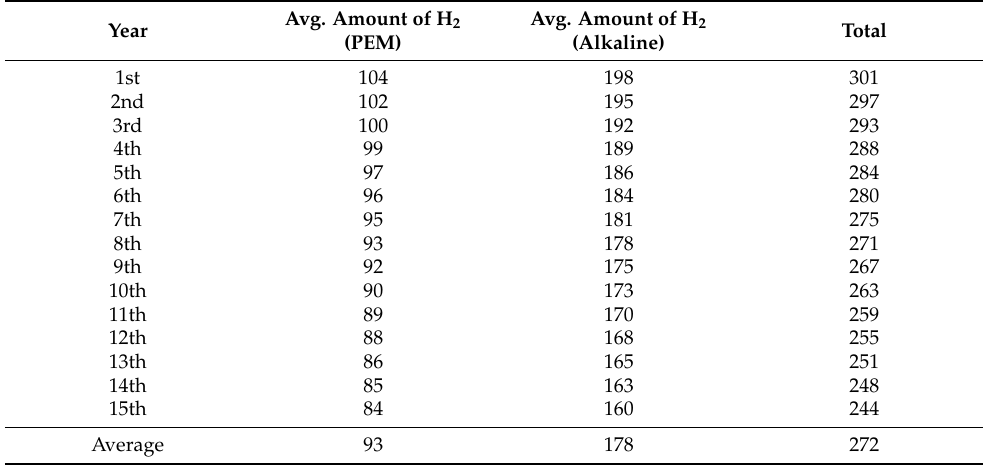
Table 45. The average daily amount of hydrogen produced for each year (Scenario